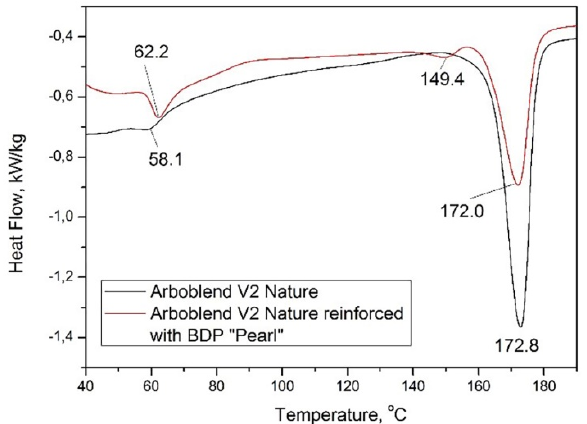
Figure 5. Highlighting the main thermal behavior of the wires made from Arboblend V2 Nature and Arboblend V2 Nature reinforced with Extrudr BDP “Pearl”.